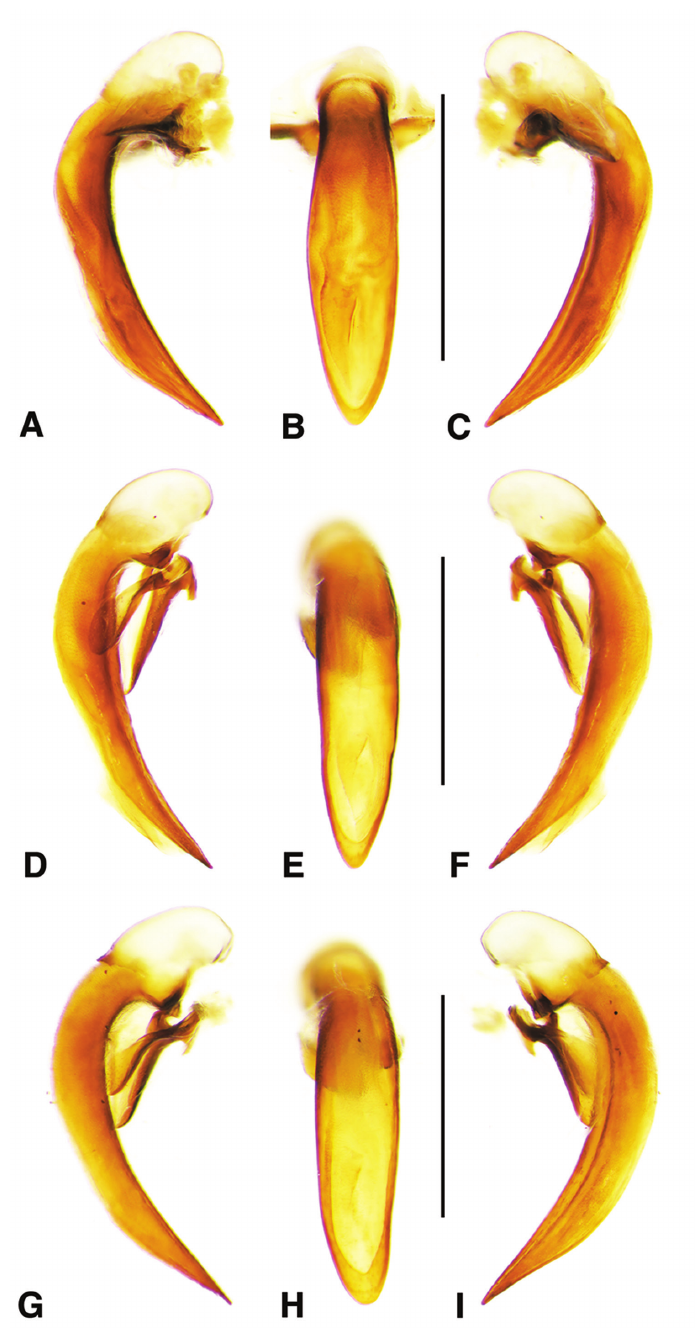
Figure 50. Digital images of male genitalia of Selenophorus palliatus species group, in part. A, D, G right lateral aspect B, E, H dorsal aspect C, F, I left lateral aspect. A–C S. alternans Dejean D–F S. palliatus (Fab- ricius) G–I S. pyritosus Dejean. Scale bars 1